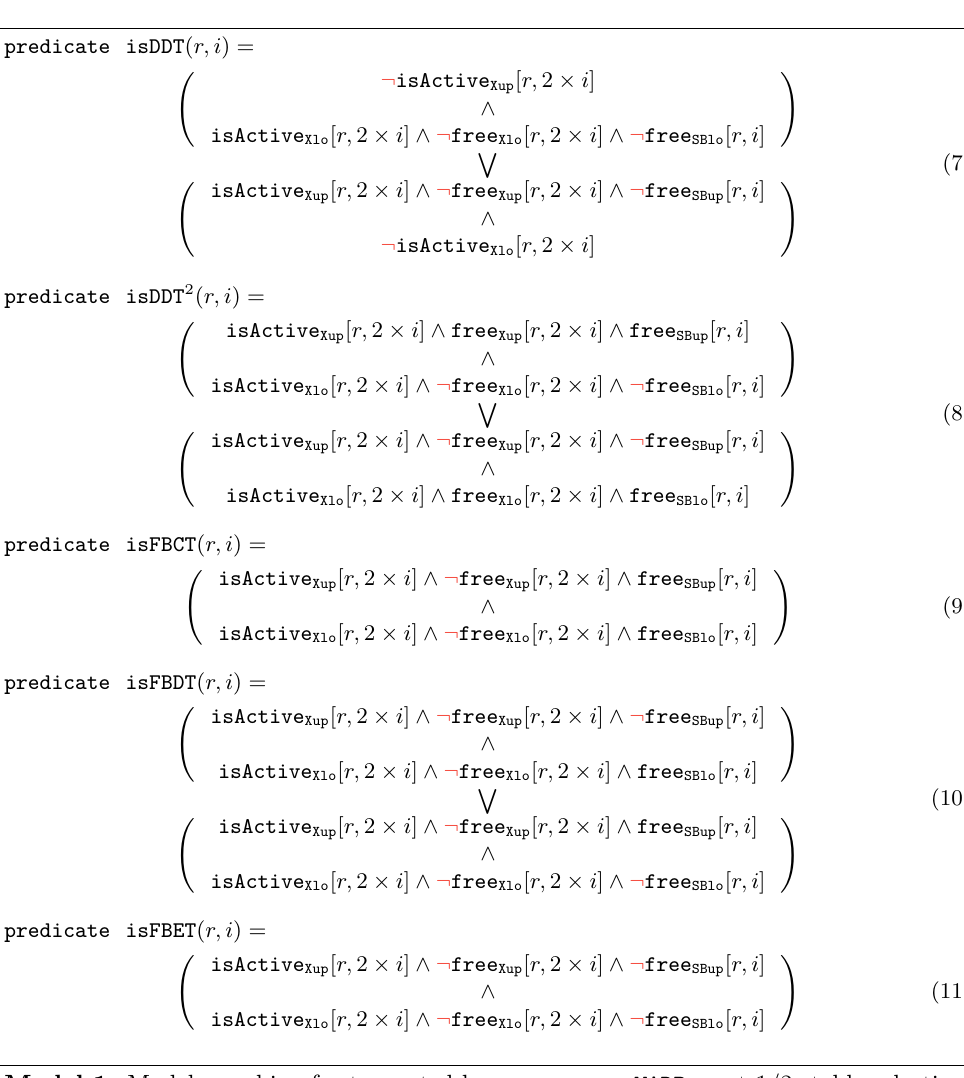
Model 1 : Model searching for truncated boomerangs on WARP , part 1/2: table